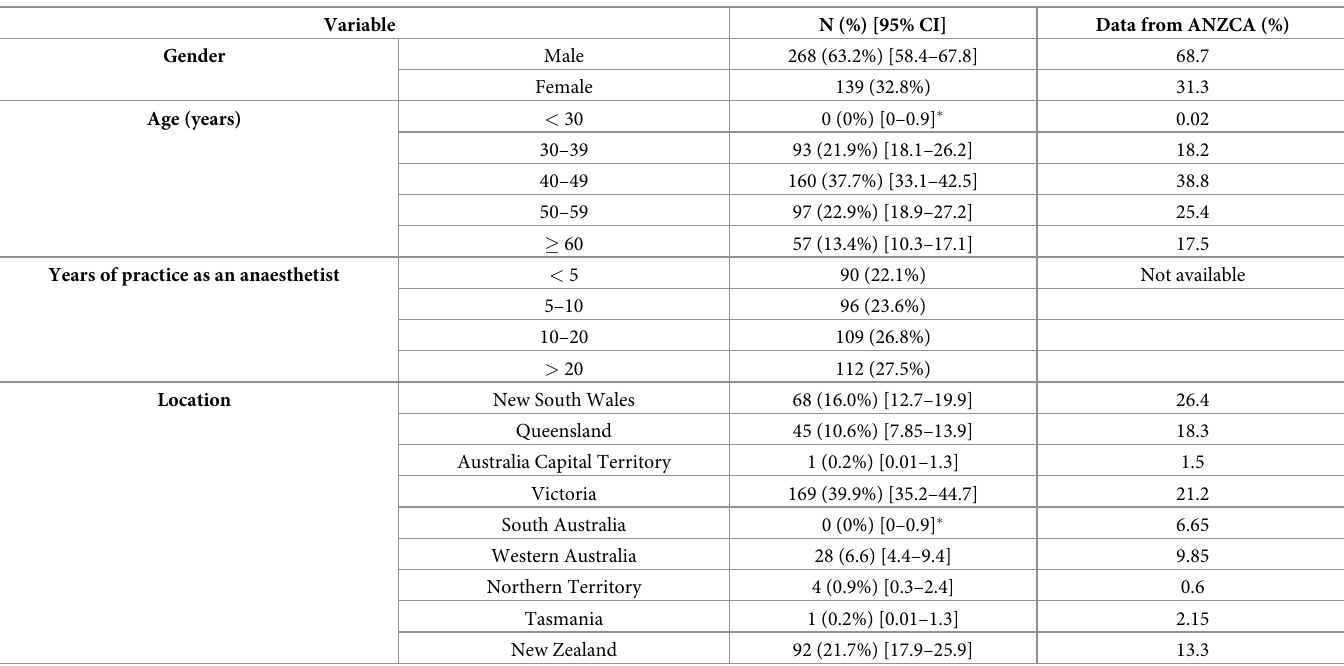
Table 1. Demographic features of participants (n =